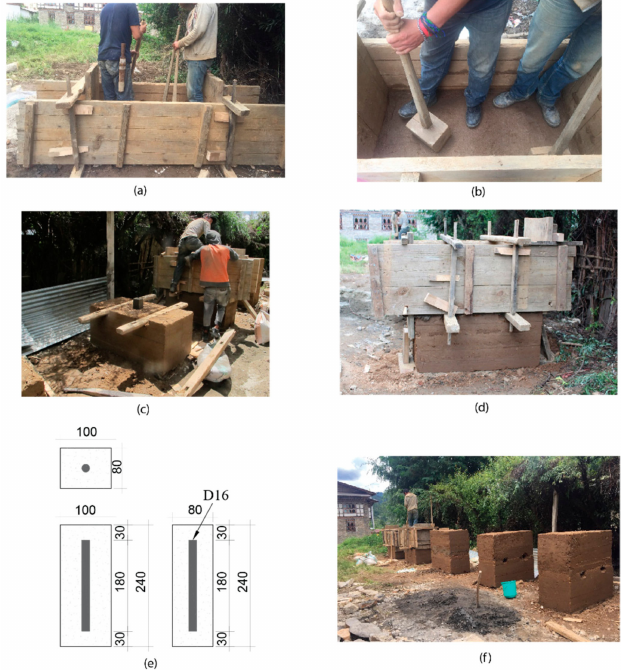
Figure 1. Rammed earth (RE) specimen construction: ( a ) formwork placement for the lower RE block; ( b ) ramming of earth soil, ( c ) insertion of the reinforced concrete (RC) dowel, ( d ) formwork placement for the upper RE block, ( e ) details of RC dowel, ( f ) completed rammed earth specimens.